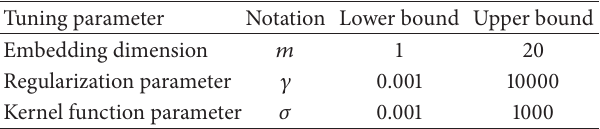
’s tuning parameters. Table 1: Ranges of the FLSVR TSP Tuning parameter Notation Lower bound Upper bound Embedding dimension 𝑚 20 Regularization parameter Kernel function